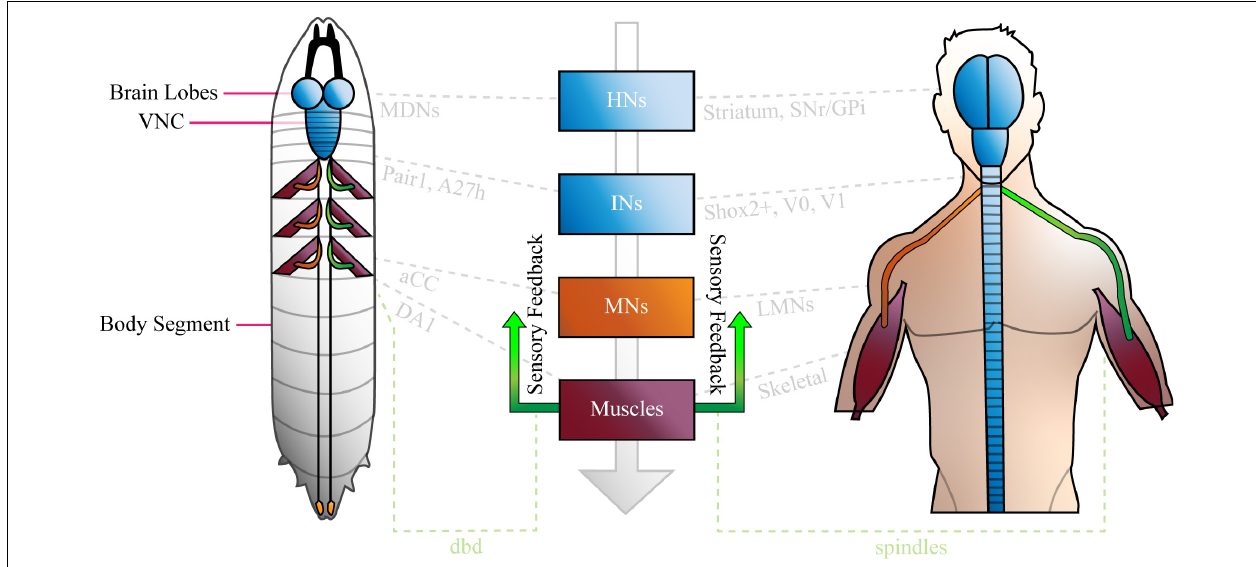
FIGURE 1 | The Basic Anatomy of the Anatomy of the Nervous System is conserved between Drosophila Larvae and Humans. The Drosophila larval nervous system is comprised of a brain (two lobes) populated by higher neurons, a ventral nerve cord (VNC) of interneurons, plus sensory inputs (green) from, and motor outputs (orange) to the periphery. The VNC is segmented, and each compartment sends nerves via central tracts, to corresponding body segments. Only three segments are shown with nerves and muscles for clarity. The human nervous system is similar, in that it features a bi-lobed brain of higher neurons, and a spinal cord of interneurons and motor neurons that is analogous to the larval VNC. Like the VNC, the spinal cord is segmented. Sensory inputs (green) and motor outputs (orange), travel to and from it, respectively. Note that both panels were designed to represent the overall organization of each nervous system simply, and not for precise anatomical correctness. Shared cell types are shown in central boxes, and examples of similar, specific brain regions, neurons and muscles are given in grey. HNs, higher neurons; INs, interneurons; MNs, motor neurons; SNr, basal ganglia; GPi, globus pallidus interna; aCC, anterior corner cell; LMNs, lower motor neurons; dbd, dorsal bipolar dendrite neuron. See “Comparison of Drosophila and Mammalian Neural Networks” for a more detailed comparison of the two nervous